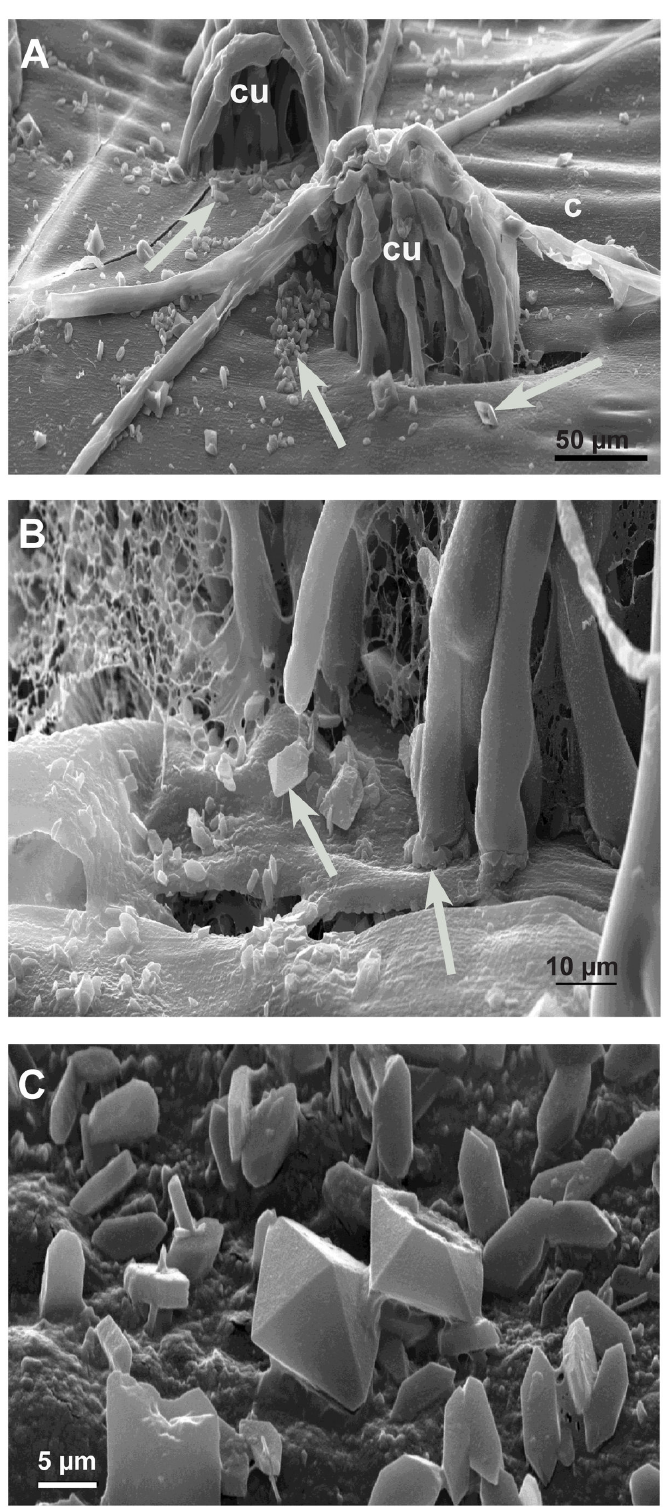
Figure 8. Calcium oxalate accumulation in the late infection stages (72 hpi) by LTSEM. Scanning electron micrographs: A : On the detached cuticle (c) calcium oxalate crystals appear (arrows) around the infections cushions (cu) B : Detail of Figure 8A showing the accumulation of crystals (arrows). C : Detail showing the variation of calcium oxalate crystals. doi: 10.1371/journal.pone.0072292.g008 PLOS ONE |